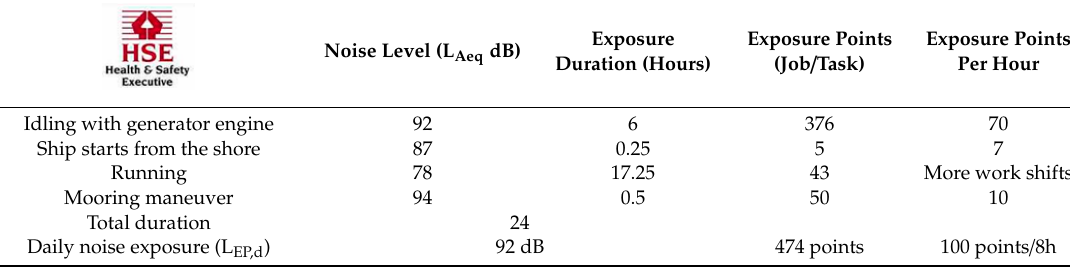
Table 2. Calculation of noise-specific parameters.